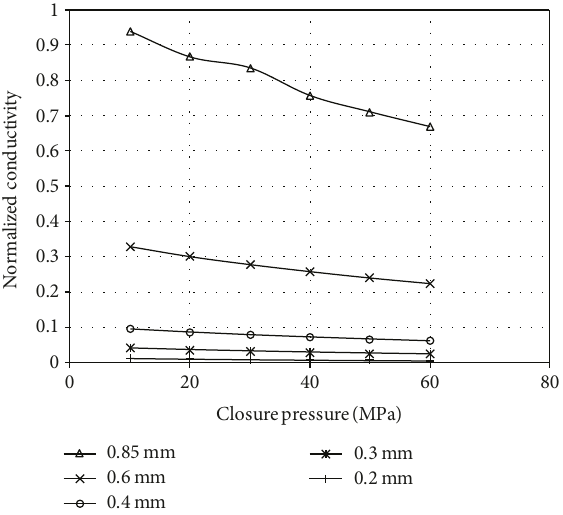
Figure 7: E ff ect of time on conductivity at di ff erent rock viscosities.